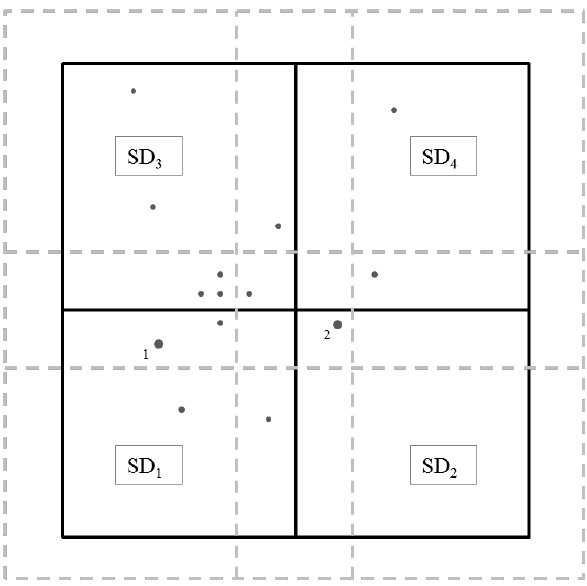
Figure 2: Buffer implementation in 2D with example data points. Each subdomain (solid black lines) is surrounded by a buffer (dashed grey lines), that therefore, overlap with each other and neighboring subdomains. Example: Point 1 belongs to SD 1 and to the buffer of SD 3 . Point 2 belongs to SD 2 , and to the buffers of SD 1 , SD 3 , SD 4 .